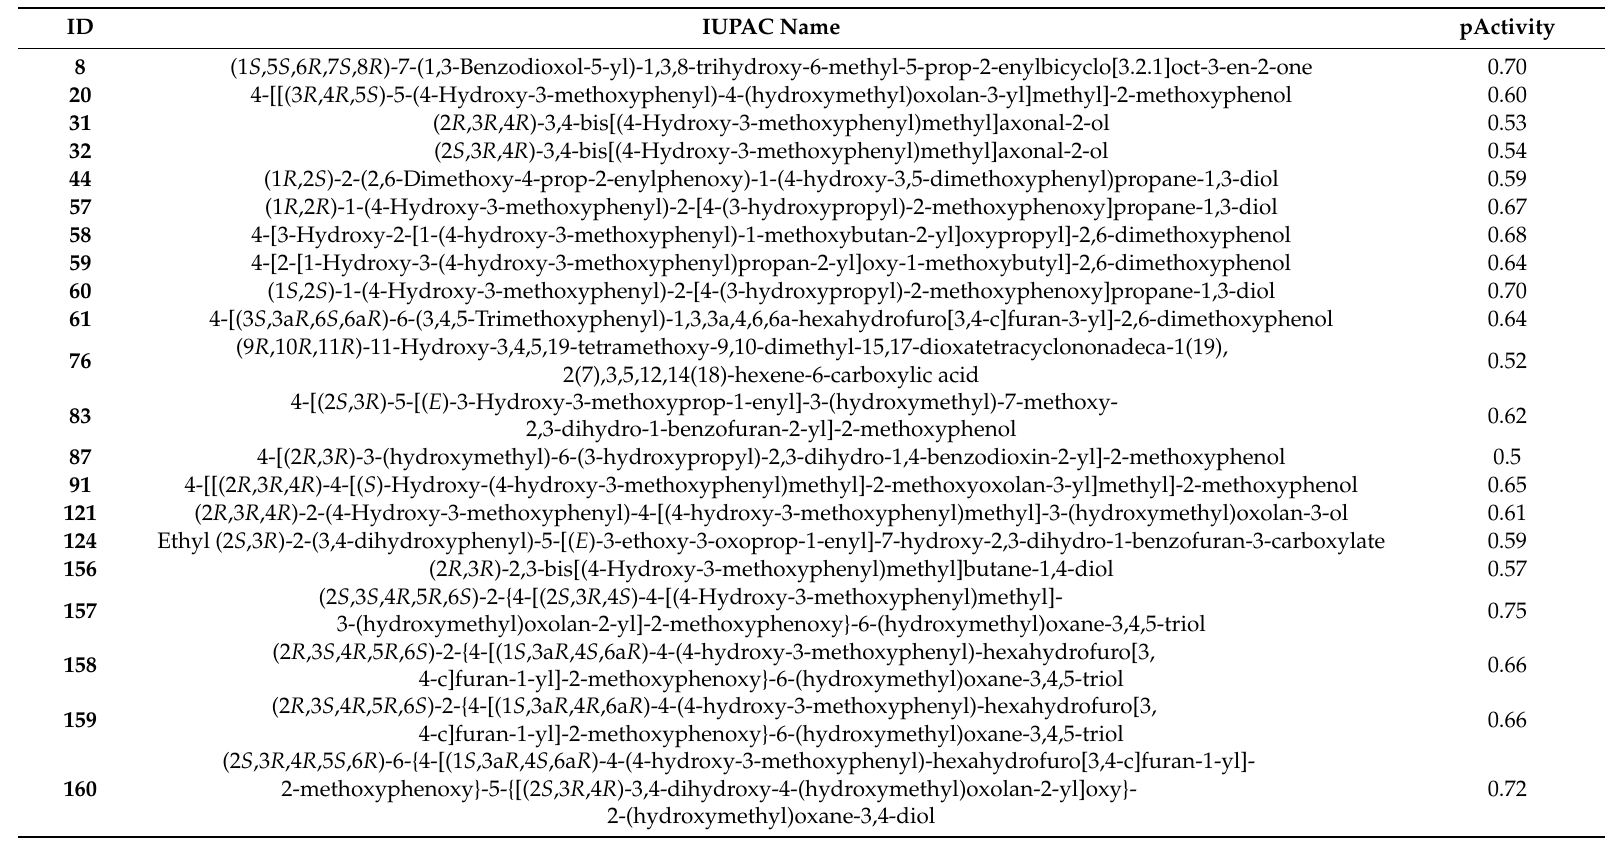
Table 3. Lignans activity probabilities (pActivity) against L. braziliensis , as assessed by the RF